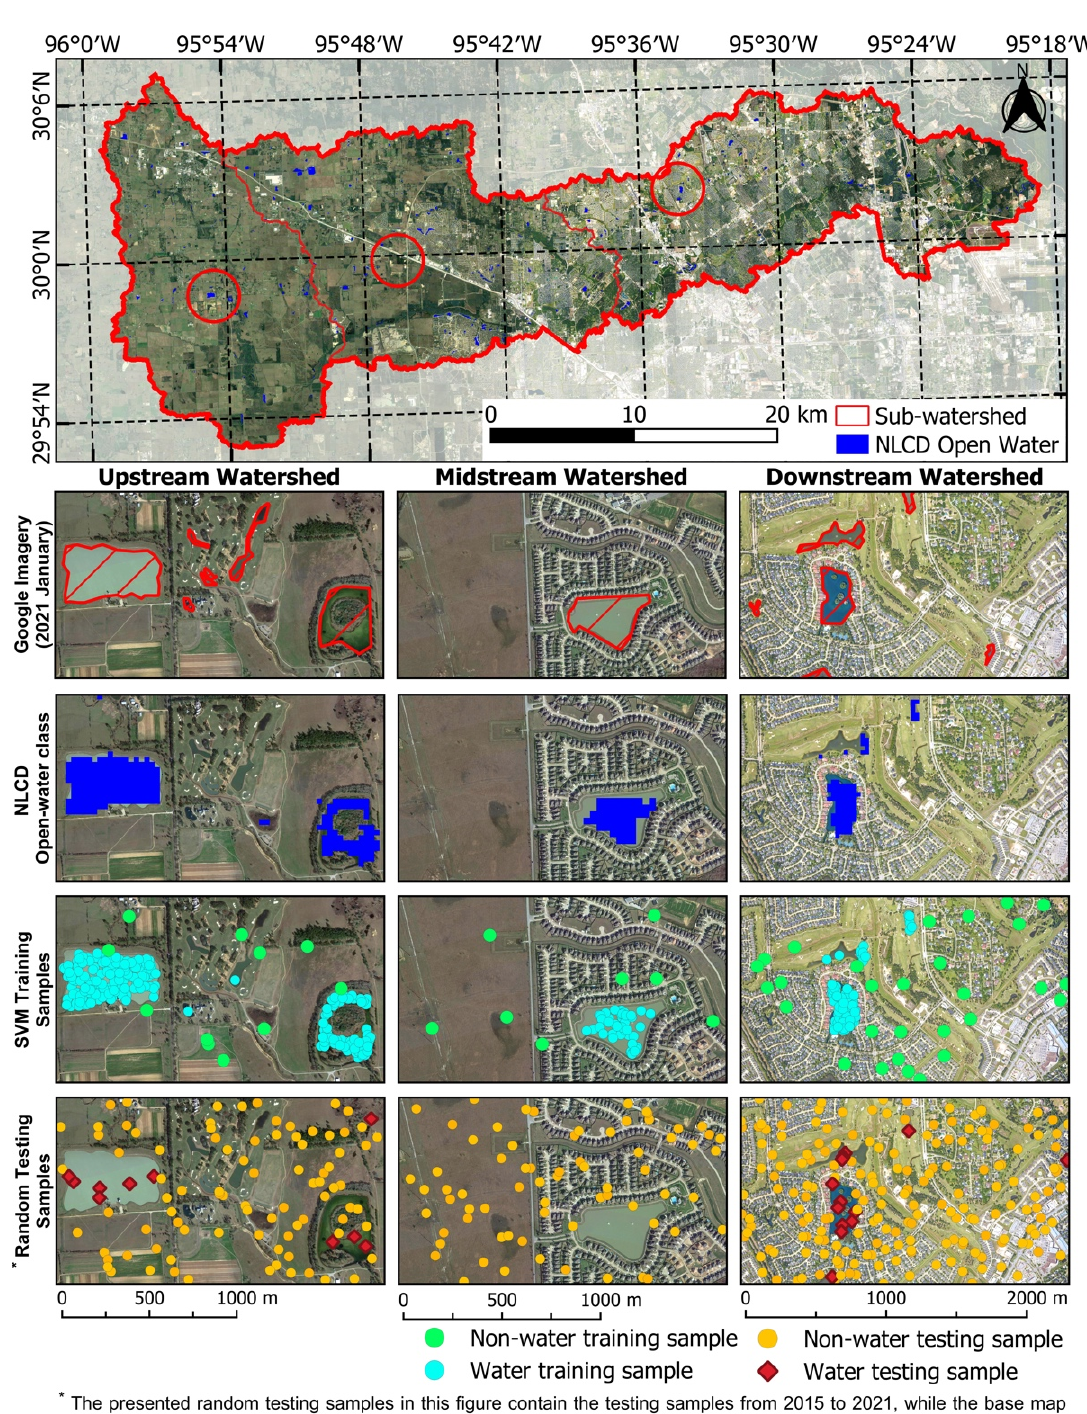
Figure 3. The ground truth sample points used for the supervised classification and the accuracy assessment within the Cypress Creek watershed.